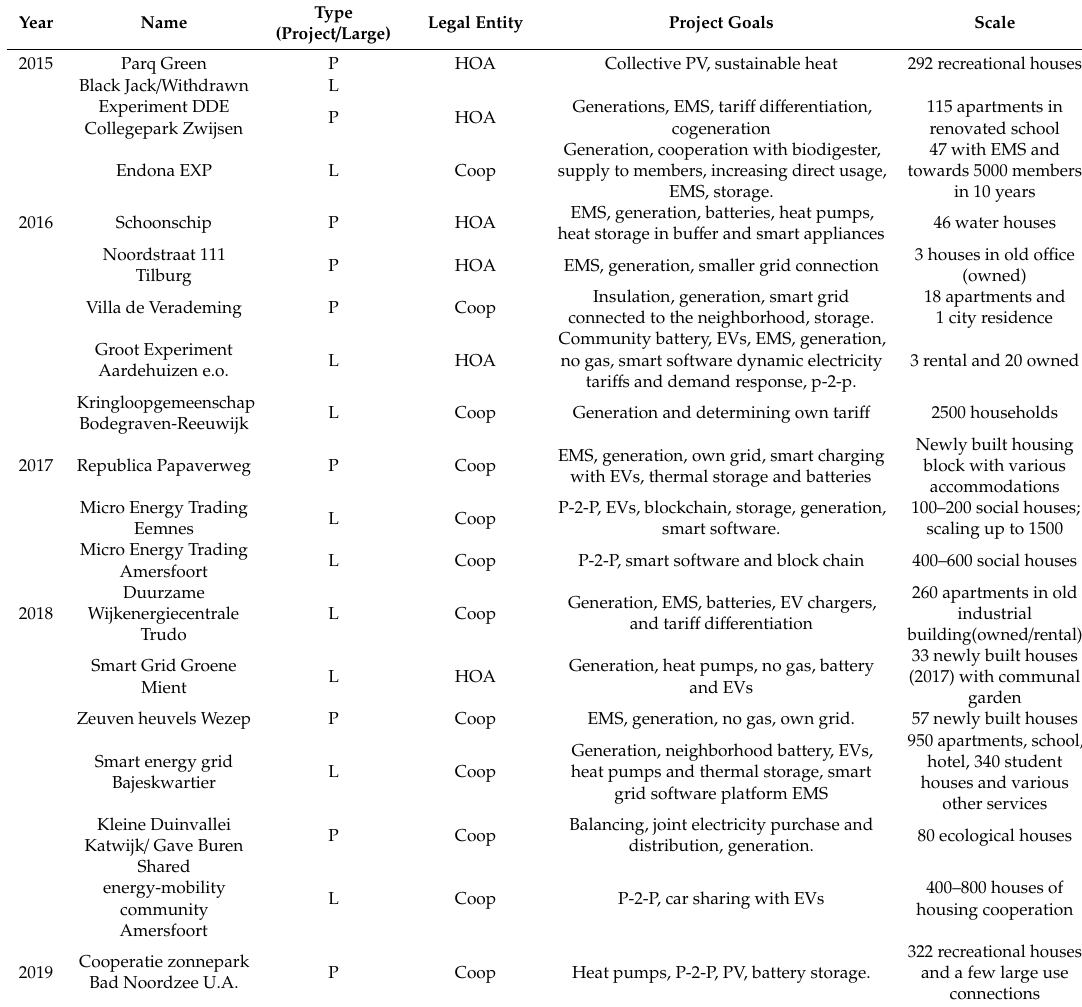
Table A1. Overview of EDSEP experiments.